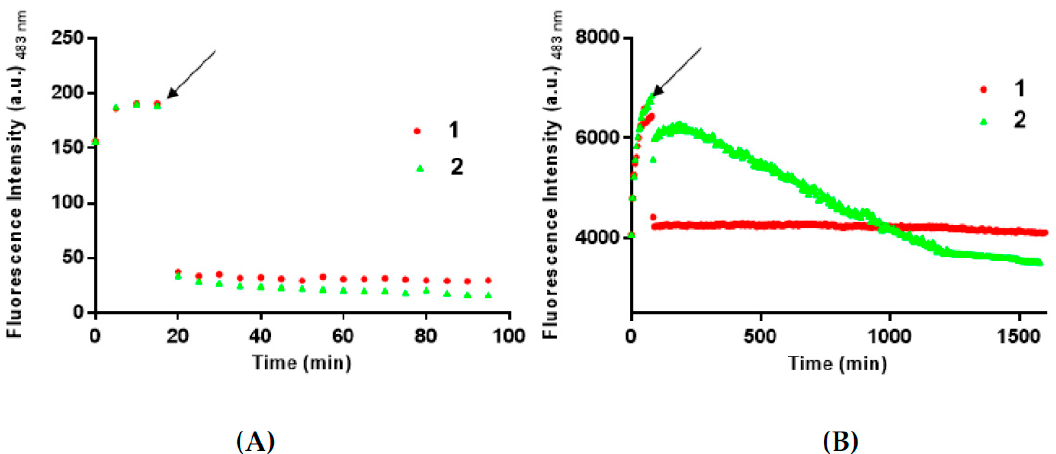
Figure 3. Time-course of ThT fluorescence emission intensity of NPM1 264–277 (panel A ) and A β 21–40 (panel B ) upon addition of 1 (red circle) and 2 (green triangle). The addition is indicated by an arrow. Results are representative of two independent experiments.